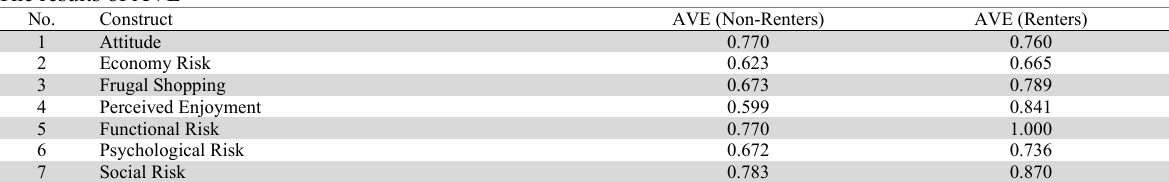
The results of AVE